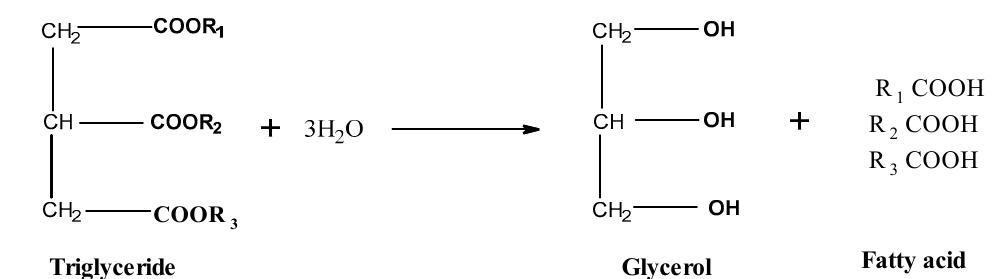
Figure 4. General schematic showing the general structure of triglycerides present in plant oils and the hydrolysis products of these triglycerides (glycerol and fatty acids). the hydrolysis products of these triglycerides (glycerol and fatty